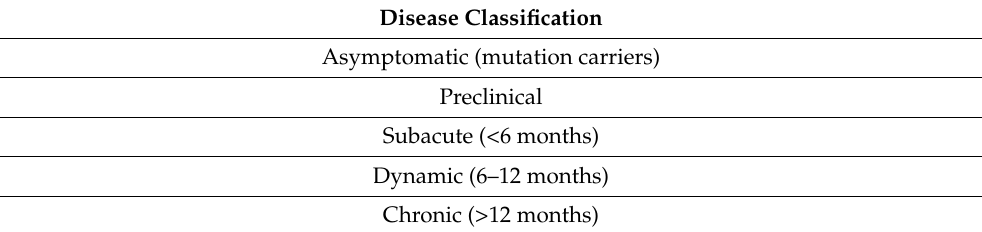
Table 1. Disease